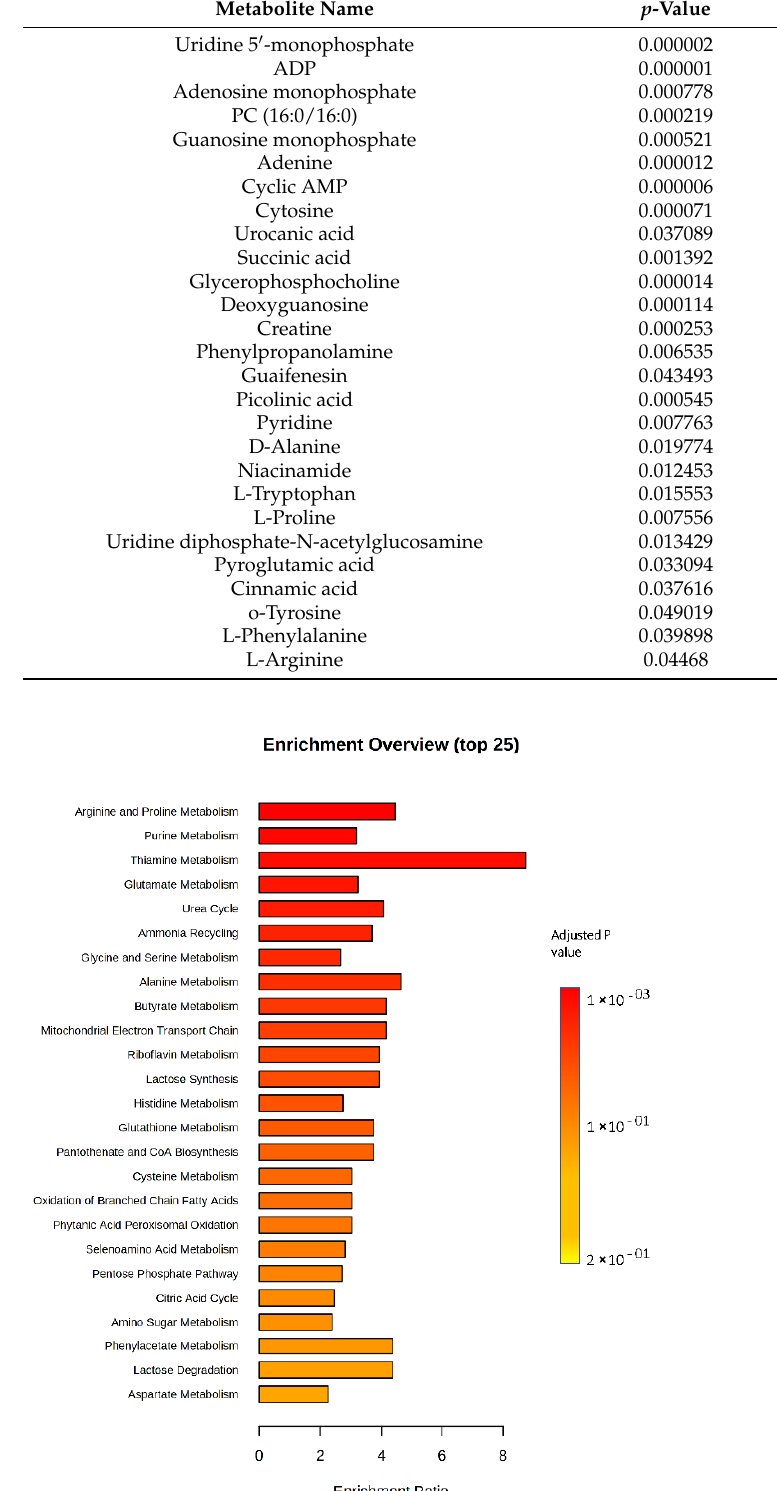
Table 1. Significant deregulated metabolites in resistant Hep3B cells in comparison to parental Hep3B cells.